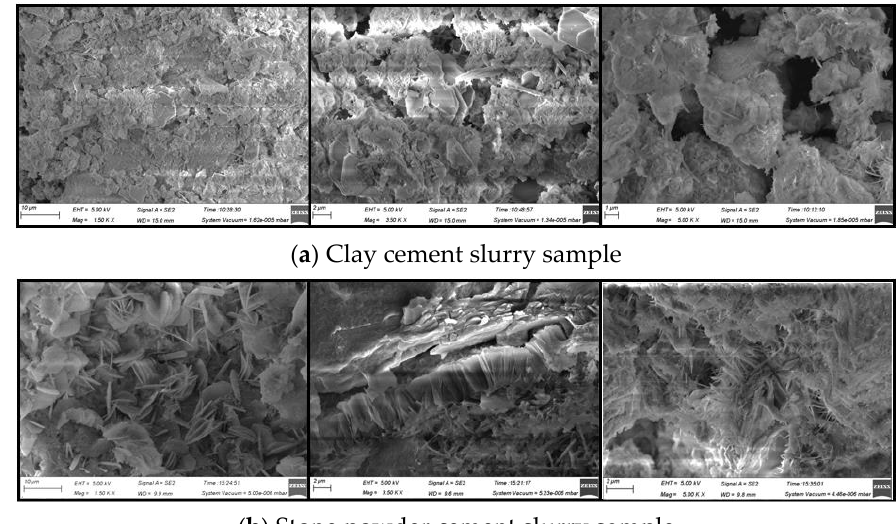
Figure 14. Sample diagram for porosity calculation.